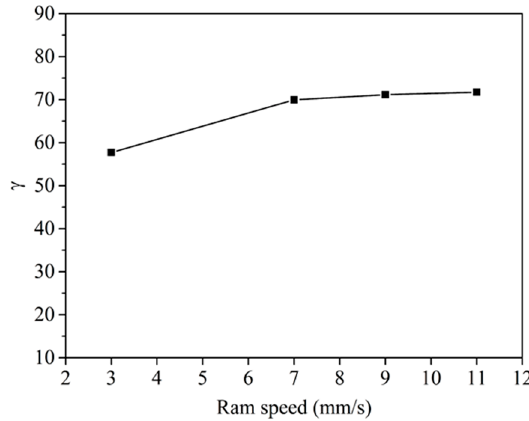
Figure 12. The relationship between the ram speed and γ value.